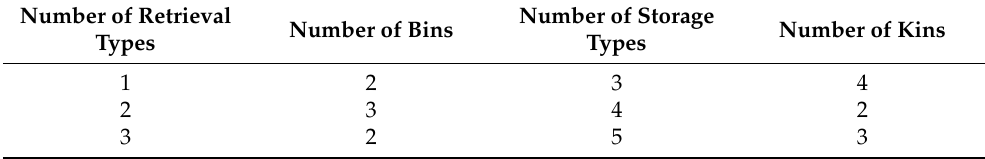
Table 1. The warehousing